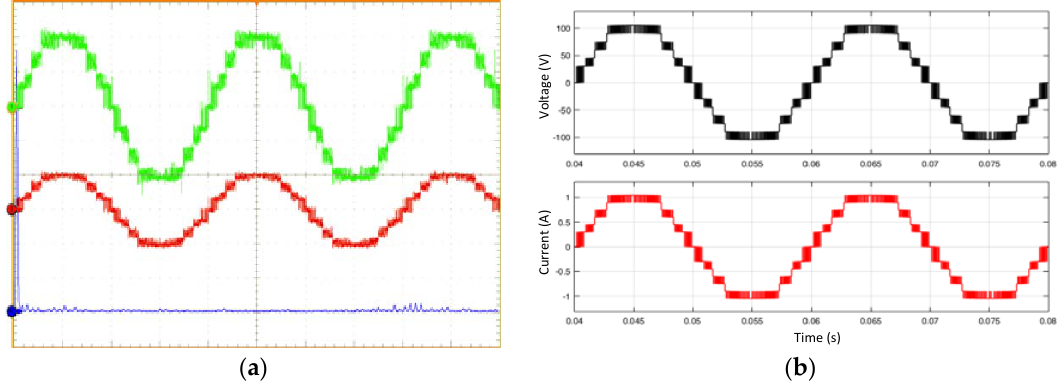
Figure 16. The output voltage (top trace) and current (bottom trace) waveforms with resistive load (50 Ω ) with the auxiliary module. ( a ) experimental ( b ) simulation result. Experimental scale (50 V/div, 1 A/div, 5.00 ms/div).